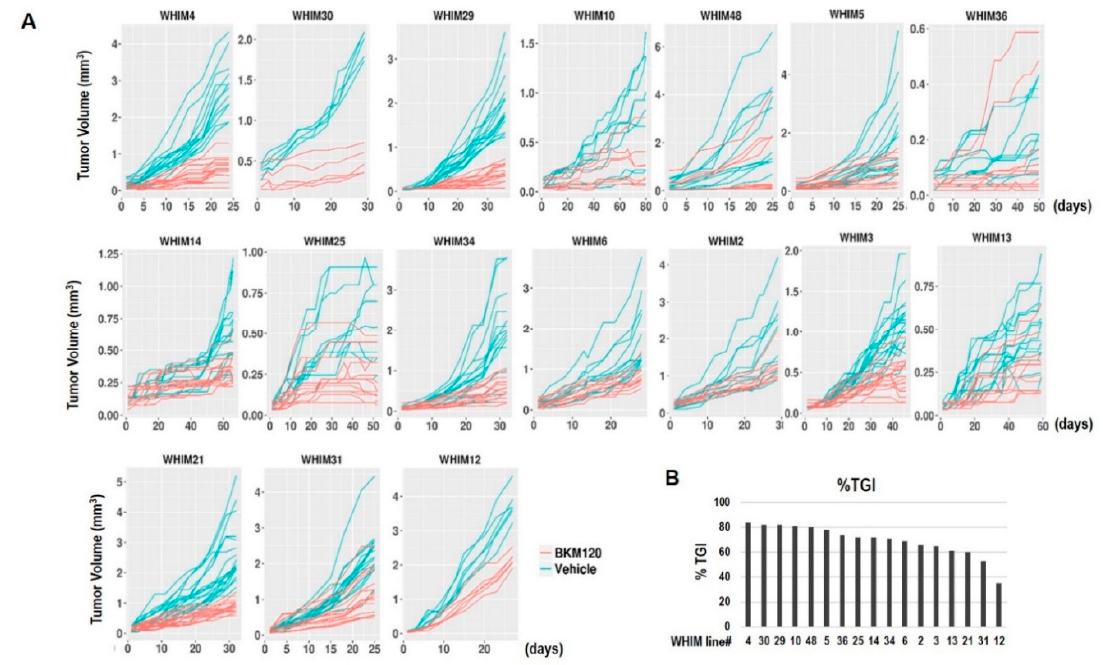
Figure 2. PDX tumor growth response to BKM120. Panel ( A ) shows tumor volume changes of individual PDX models over time in response to treatment with either vehicle or BKM120 30 mg / kg orally days 1–5 each week. Each line represents a single tumor. Panel ( B ) shows the bar graph of the percentage tumor growth inhibition (%TGI) at the completion of the experiments for each PDX model.